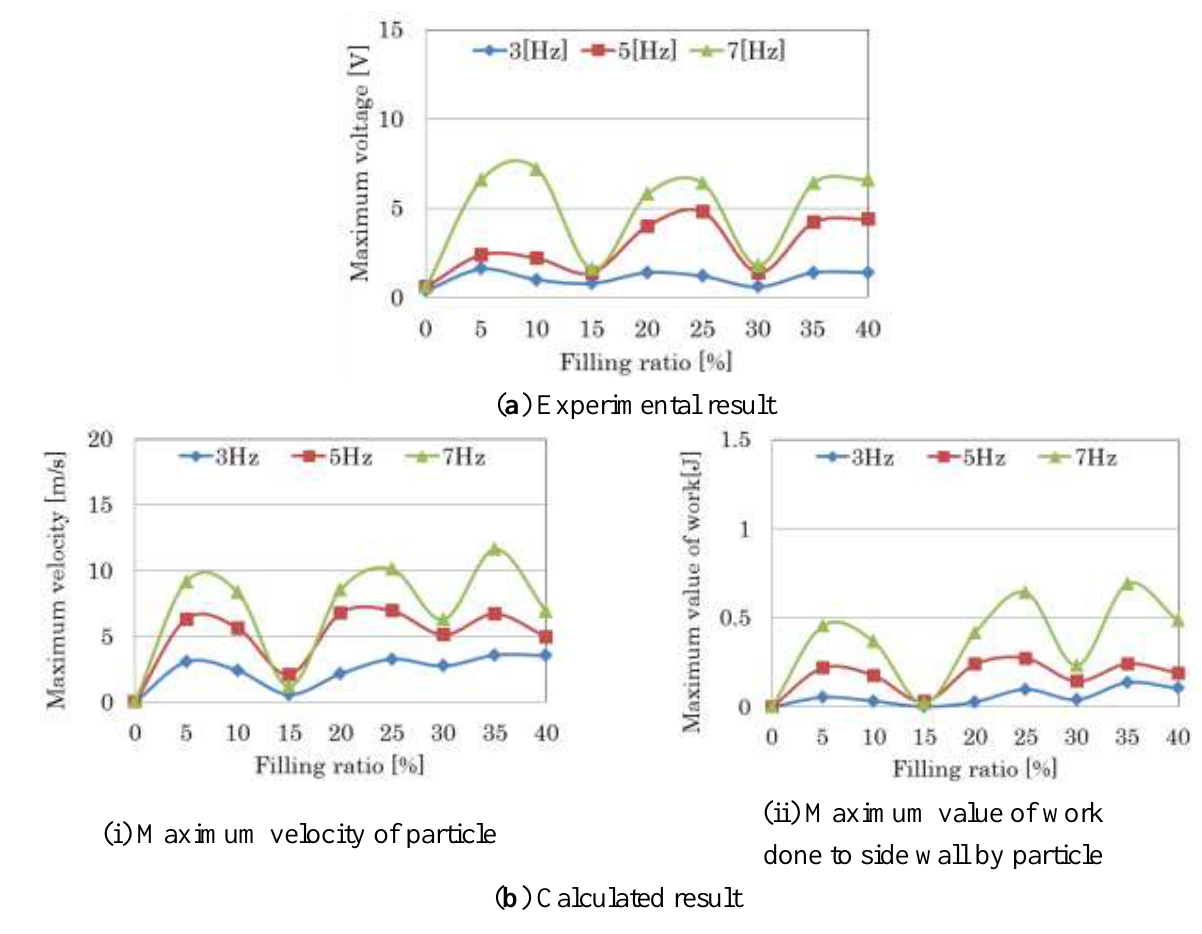
Figure 6. Relationship between frequency of container and filling ratio ( P d = 12.7 mm, D = 50